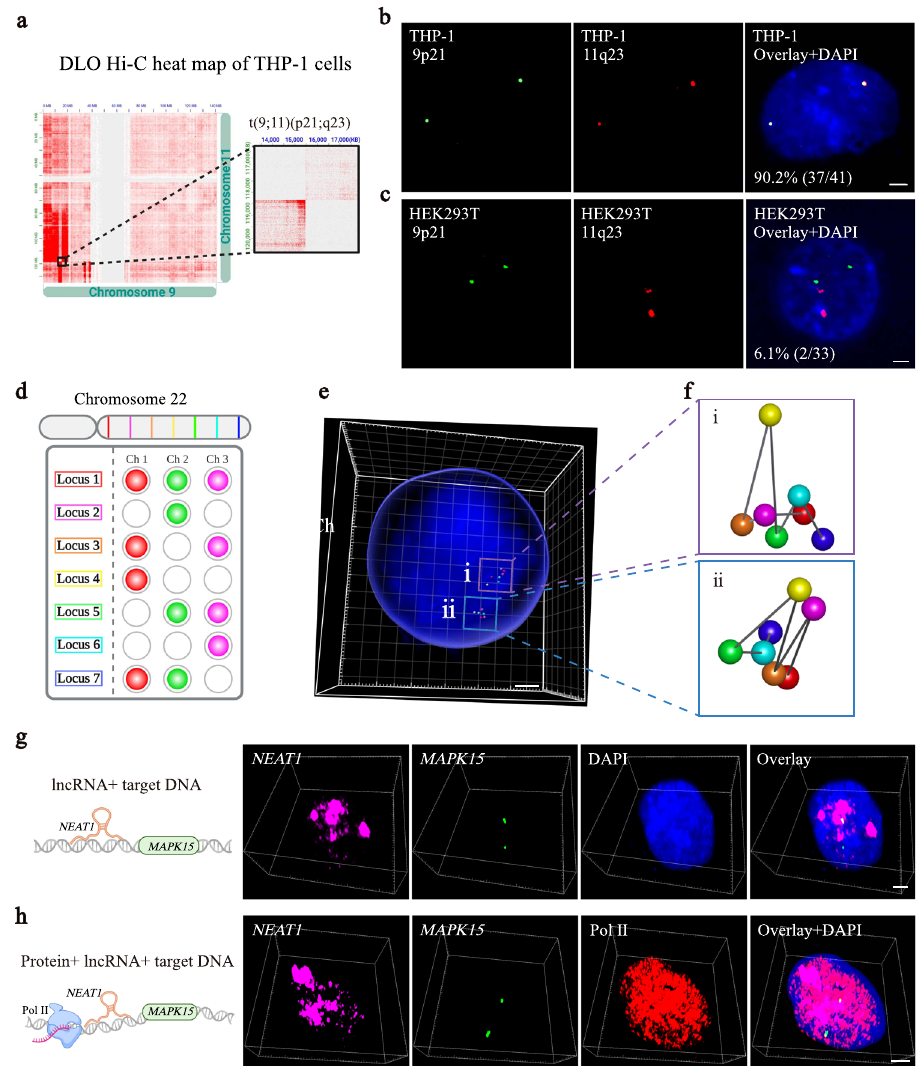
Fig. 4 | Simultaneous in situ detection of DNA, RNA, and proteins by π -FISH rainbow. a A putative translocation site between chromosomes 9 and 11 in THP-1 cells according to the DLO Hi-C data. b , c Detection of translocation sites in chromosomes 9 (green) and 11 (red) by π -FISH rainbow in THP-1 cells ( d ) and control HEK293T cells ( e ) con fi rmed the translocation in THP-1 cells. Scale bars, 2.5 μ m. d Schematicfordetectingsevenlocionthelongarmofchromosome22by π -FISH rainbow based on single and merged signals from three fl uorescent chan- nels:Ch1,channel1;Ch2,channel2;Ch3,channel3. e Thehybridizationsignalsfor seven loci (rectangular box i and ii) on the long arm of chromosome 22 were